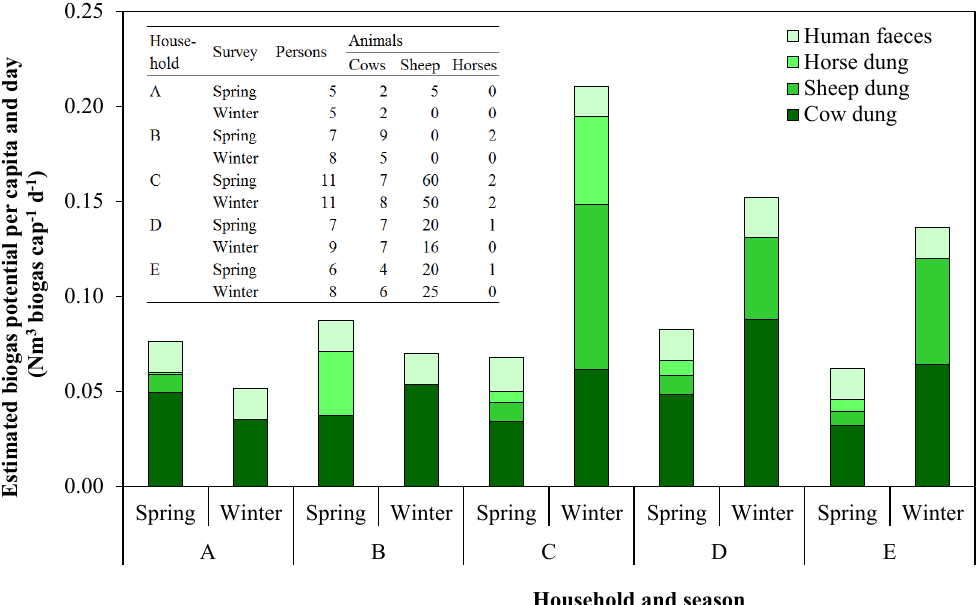
Fig. 3. Estimated daily biogas potential per capita and season (Nm 3 cap (cid:1) 1 d (cid:1) 1 ) for surveyed households; inlet: household overview with mean number of persons and animals present during spring and winter